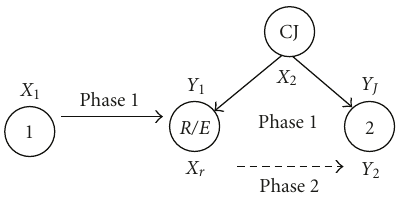
Figure 2: Two-hop network with an external cooperative jammer,